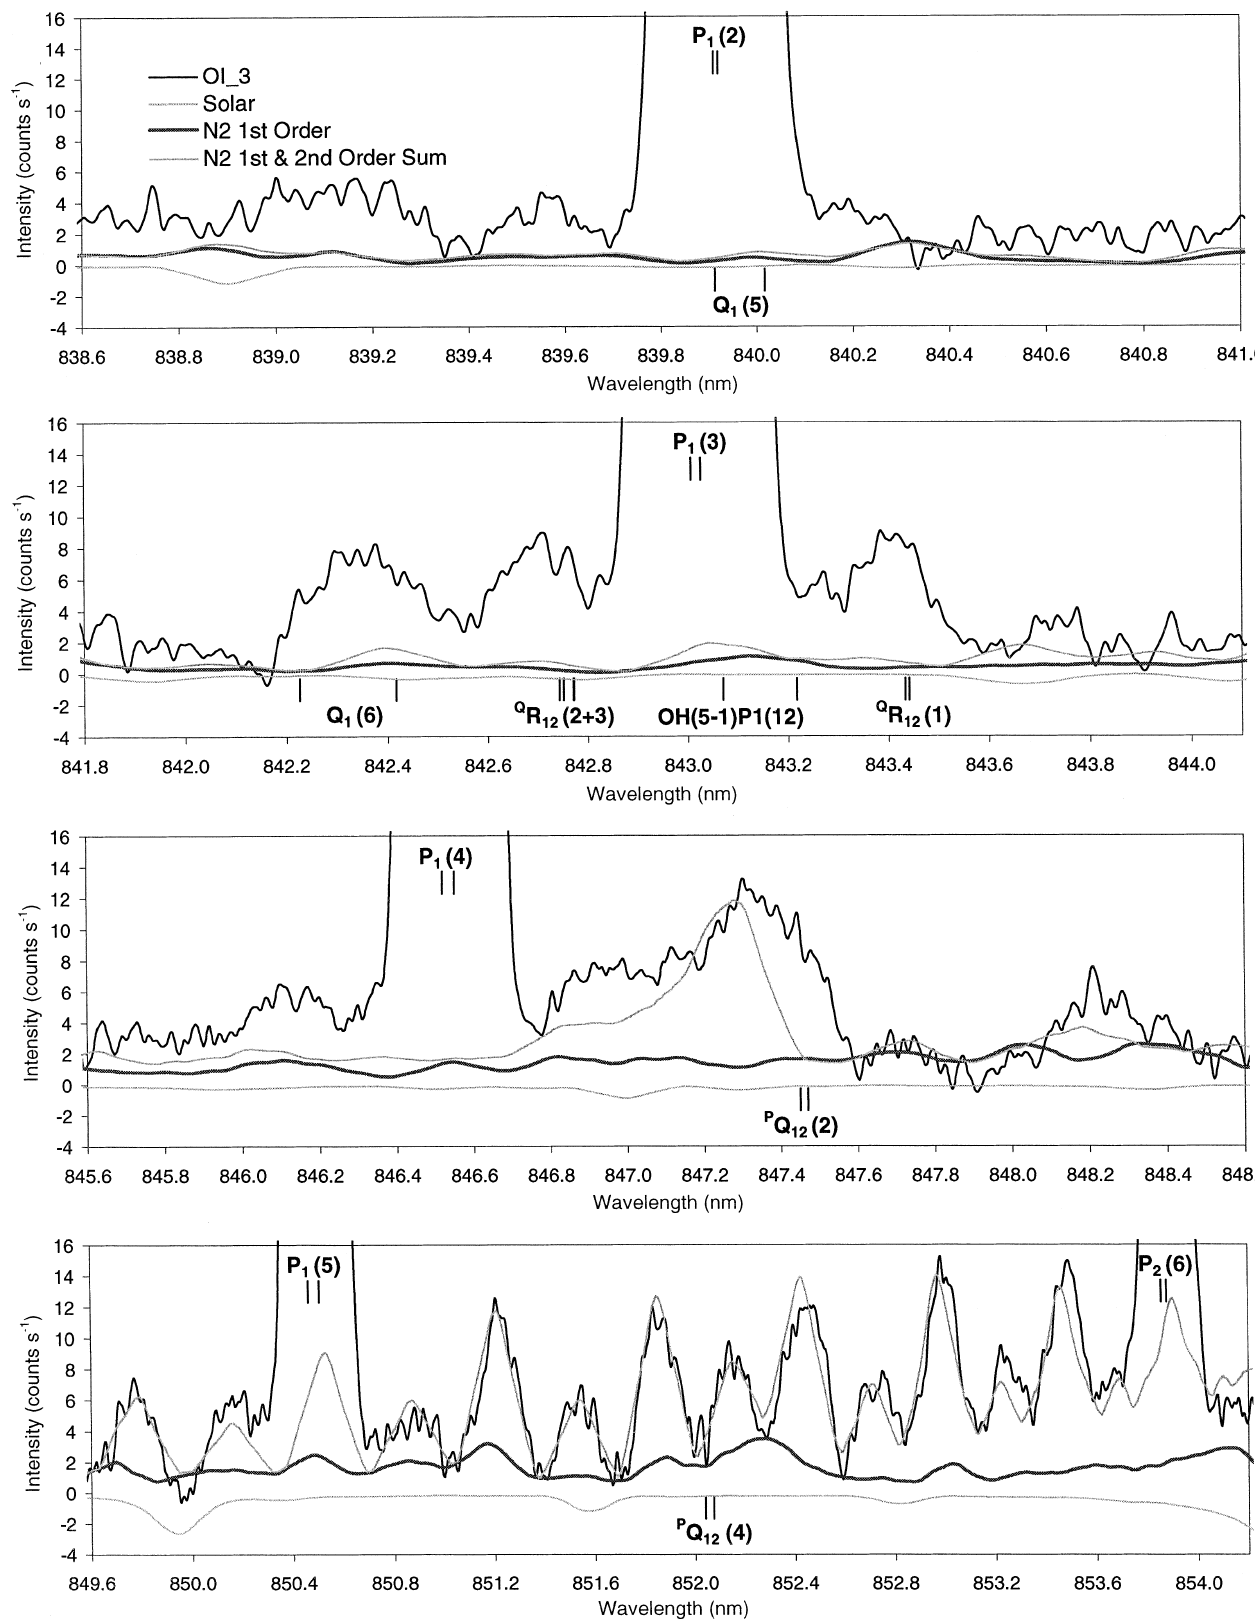
Fig. 3. The most aurorally active spectrum from Fig. 2, for which OI = P 1 (cid:133) 3 (cid:134) average (cid:136) 1 : 15, and showing theoretical first and second- order N 2 band auroral contamination fitted to the data and the